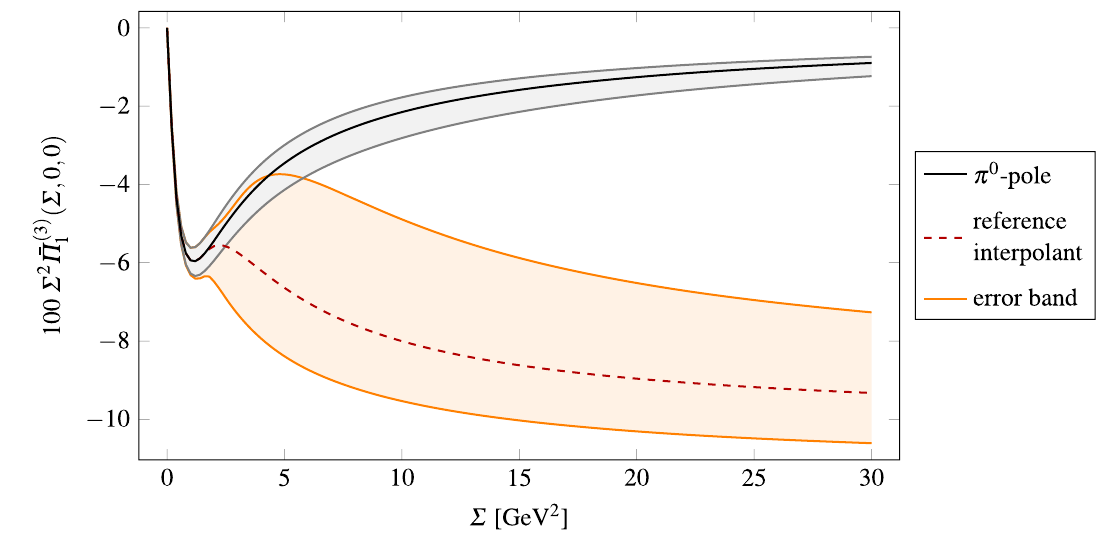
Fig. 2 The pion pole contribution and associated uncertainty from Refs. [13,14] vs. the reference interpolant and its error band which includes all sources of uncertainty considered in the present analysis (see discussion in Sects. 5.1.1–5.1.4